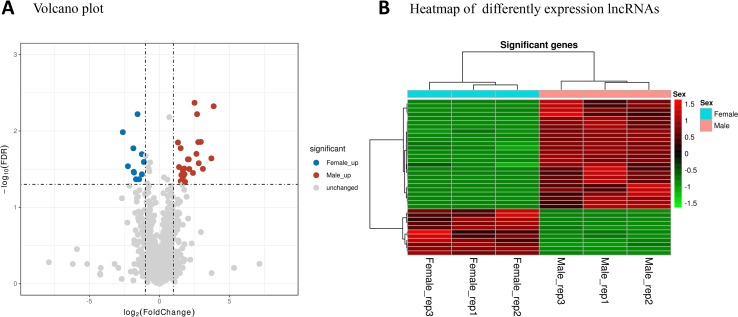
lncRNA expression profiles in male and female Ae. albopictus mosquitoes. (A) Volcano plot analysis of lncRNA expression variation between males and females. Red and blue points correspond to 2.0-fold changes in male/female high-expression mRNAs, respectively, and indicate FDR  < 0.05. (B) Hierarchical clustering of the differentially expressed lncRNAs. Green represents low expression levels and red represents high expression levels.